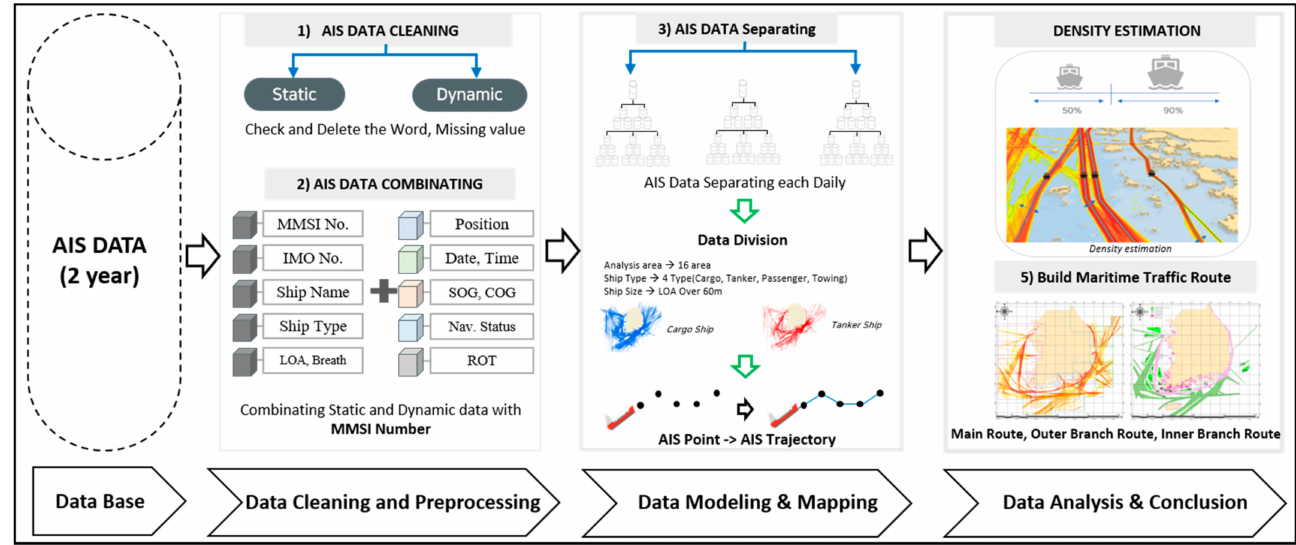
Figure 2. Research of the flow chart of Korean maritime traffic